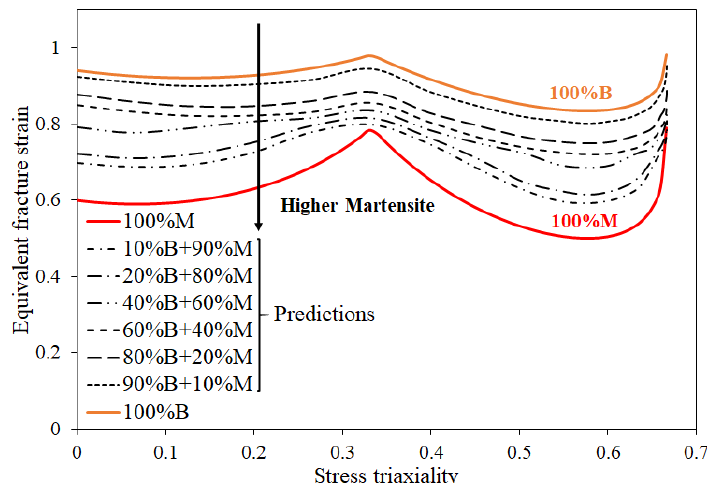
Figure 22. The predicted fracture loci for Ductibor ® 1000-AS bainitic-martensitic microstructures with various phase amounts (%v) using the established numerical scheme. The 100%B and 100%M fracture loci are also displayed for the reference.